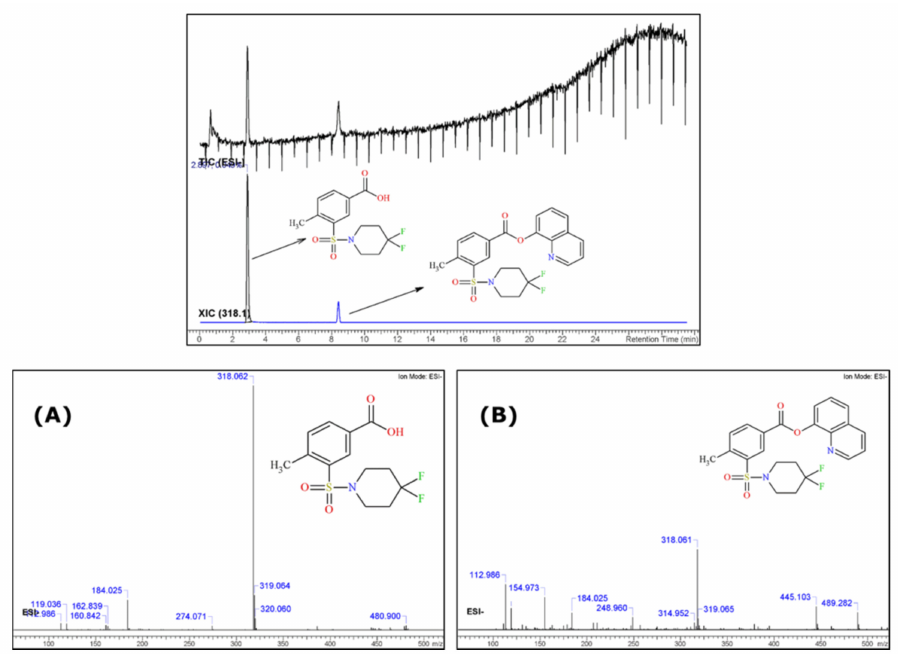
Figure 5. UHPLC-ESI (-) qTOF-MS TIC and ESI(-) MS spectra of the identified precursor 2F-MPSBA ( A ) and of the identified cannabinoid 2F-QMPSB ( B